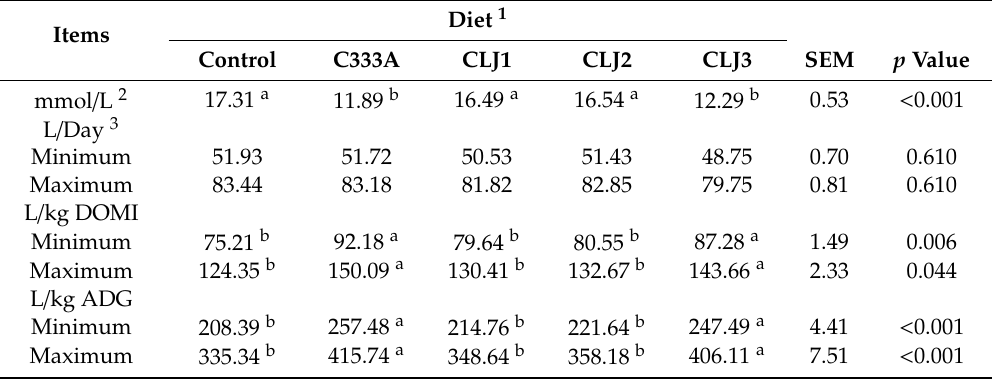
a,b Means within a row with di ff erent subscripts di ff er when p < 0.05. 1 ADG, average daily gain; Control, diet containing alfalfa hay; C333A, diet containing 333A stover; CLJ1, diet containing Lanjian No. 1 stover;